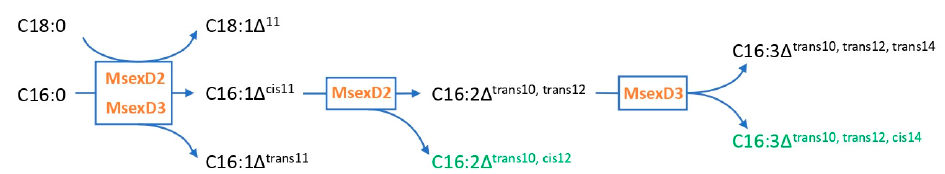
Figure 8. Manduca sexta metabolic pathway of pheromone precursors synthesis by MsexD2 and MsexD3 enzymes. Items highlighted orange are enzymes. Those highlighted green are main pheromone precursors.